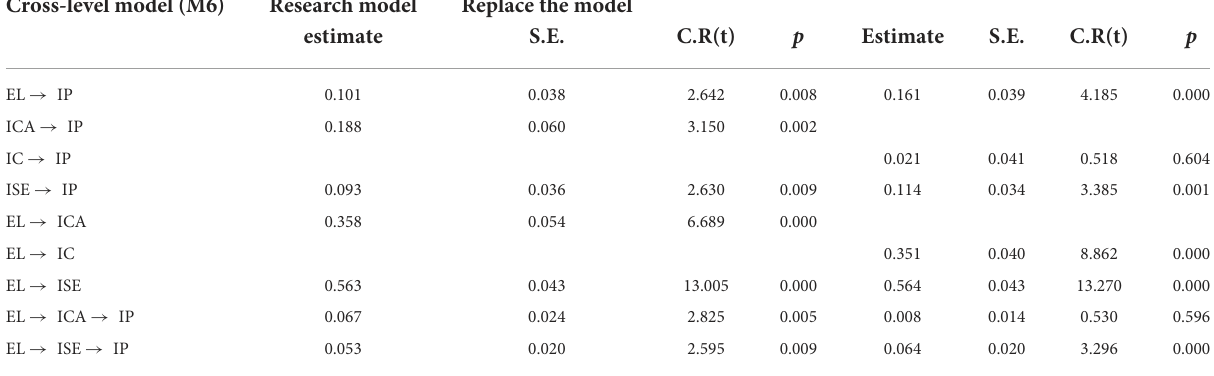
TABLE 5 Cross-hierarchical models contain all